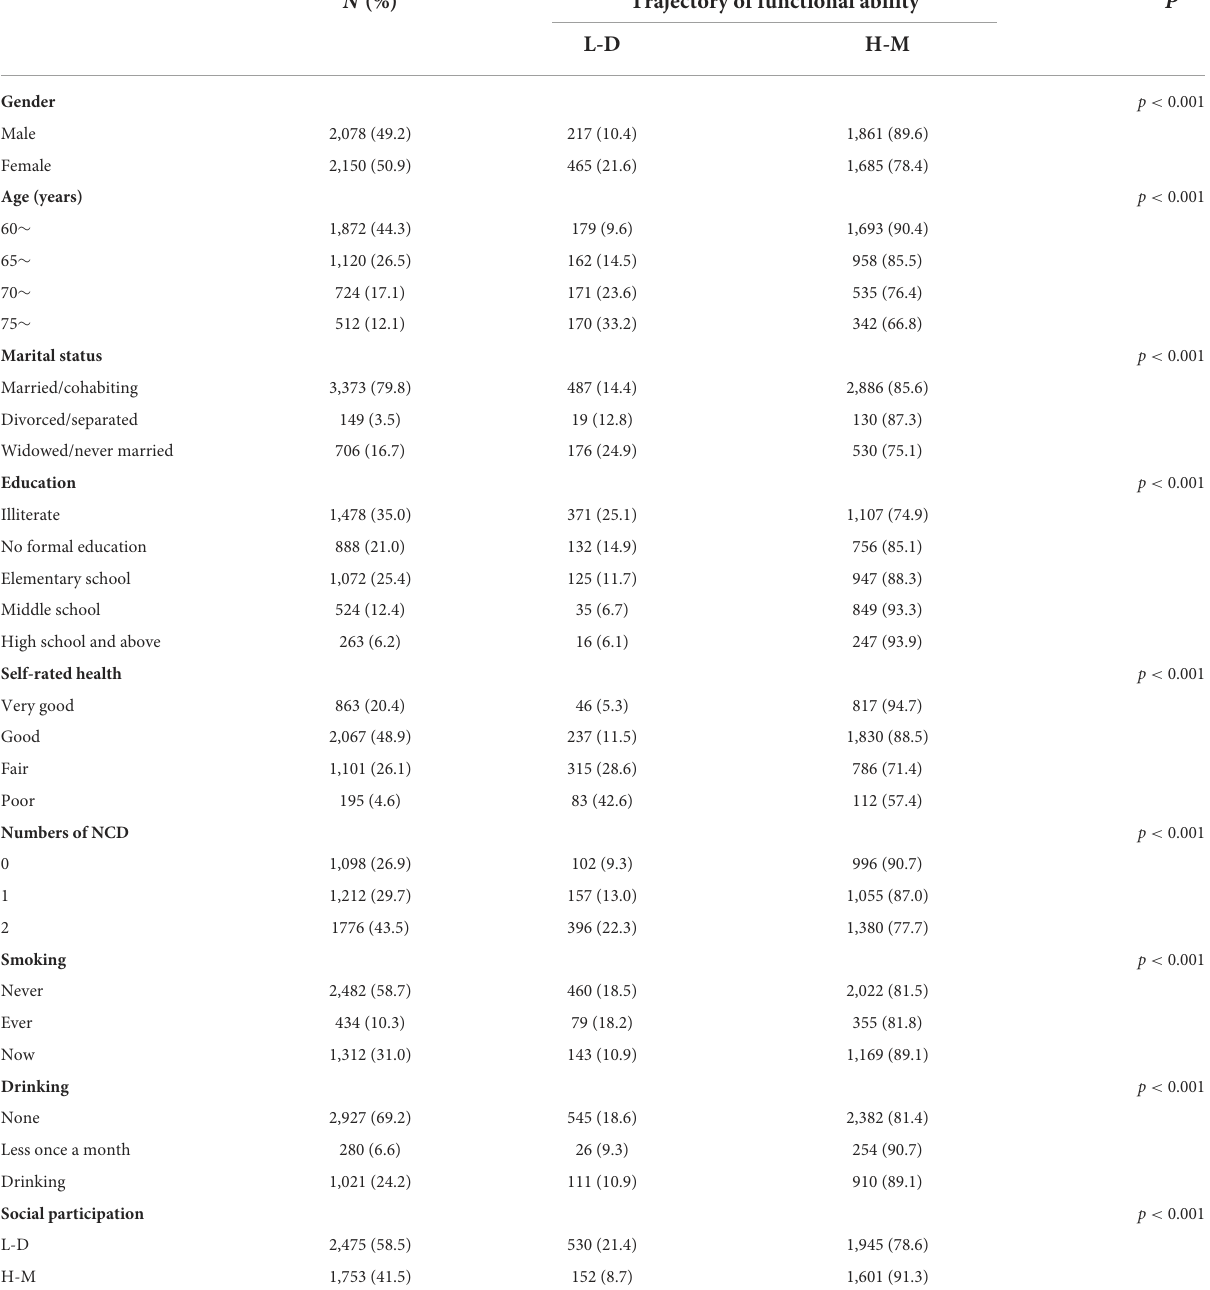
TABLE 1 Baseline sample characteristics and the sample by the different trajectory of functional ability. N (%) Trajectory of functional ability P L-D